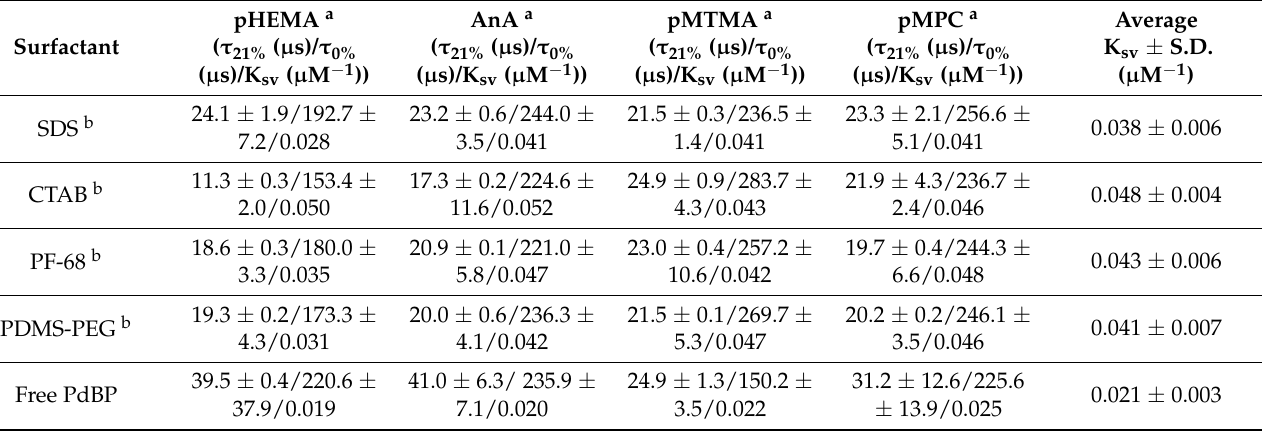
Figure 3 . Comparison of oxygen sensitivity for nanoparticles stabilized with different surfactants. Panel ( A ) contains the Stern–Volmer plot for ethyl cellulose NPs dispersed in alginate. Panel ( B ) shows the Stern–Volmer plot for polystyrene NPs dispersed in alginate. The Stern–Volmer constant (K sv ) of each formulation of NPs is given in the legend within parenthesis (unit for K sv is µ M − 1 ). Table 1. The effect of hydrogel matrix on oxygen sensitivity of ethyl cellulose nanoparticles (EC NPs) coated with different